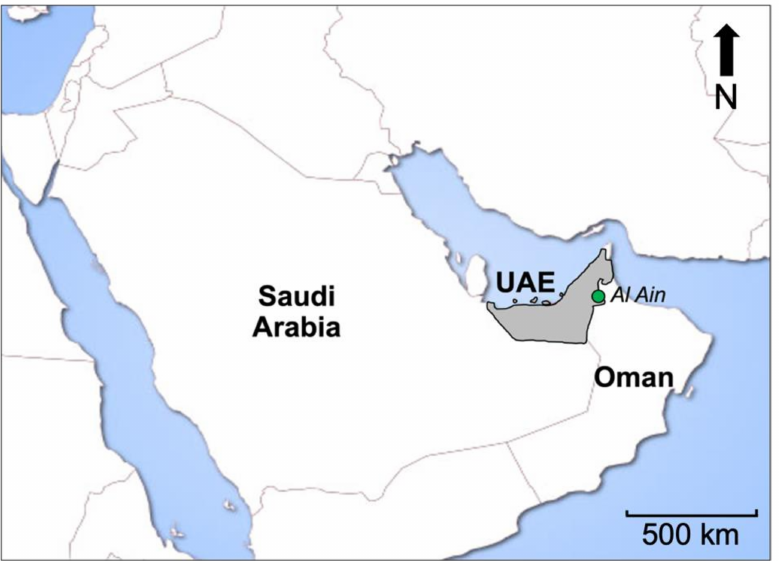
Figure 1. Map of the Arabian Peninsula showing the location of Al Ain (green dot) in the UAE (grey coloured region). Modified from www.freeworldmaps.net (accessed on 18 September 2020).